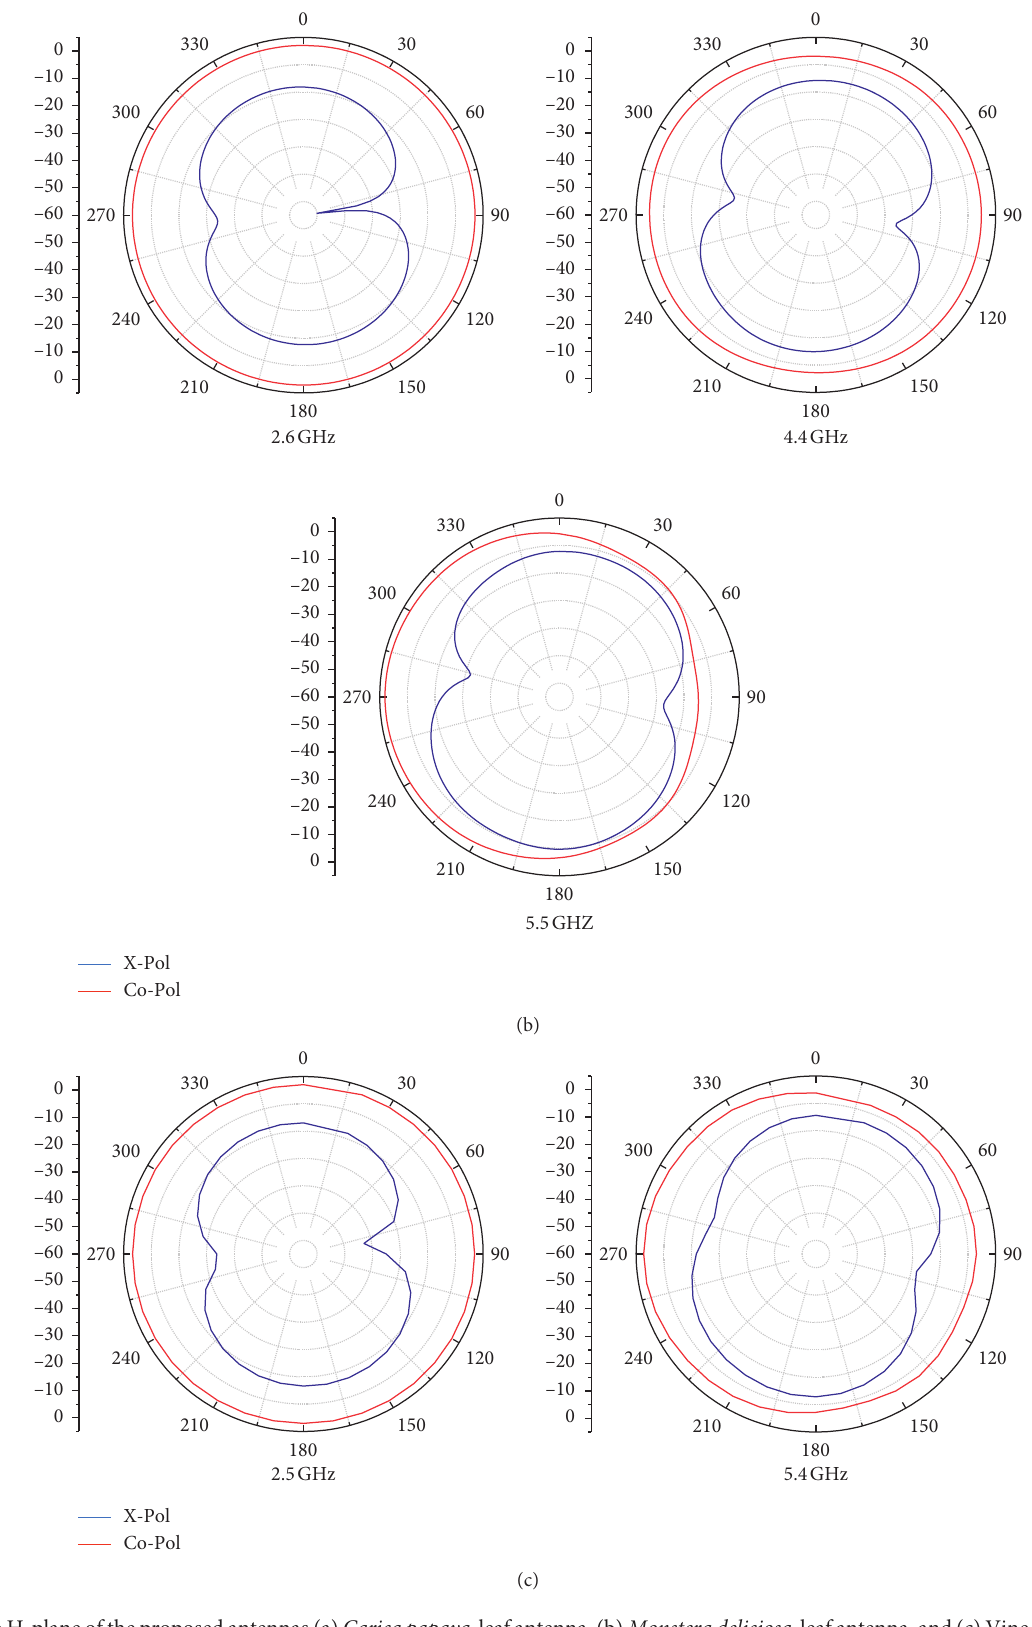
Figure 12: H-plane of the proposed antennas (a) Carica papaya -leaf antenna, (b) Monstera deliciosa -leaf antenna, and (c) Vine-leaf